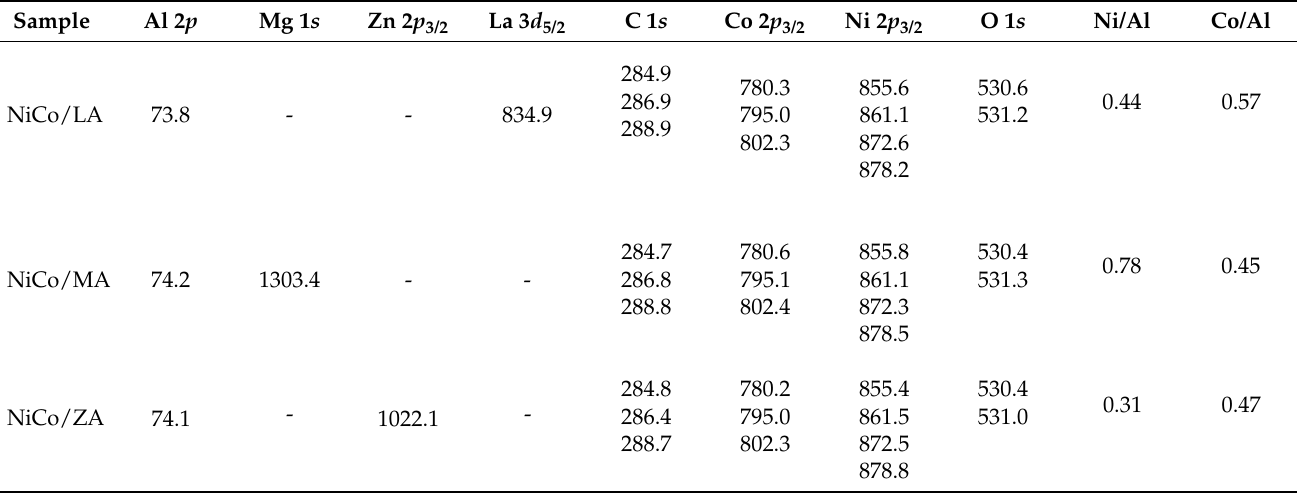
Table 3. Binding energies values (eV) and Ni/Al and Co/Al ratios obtained from XPS spectra of the supported